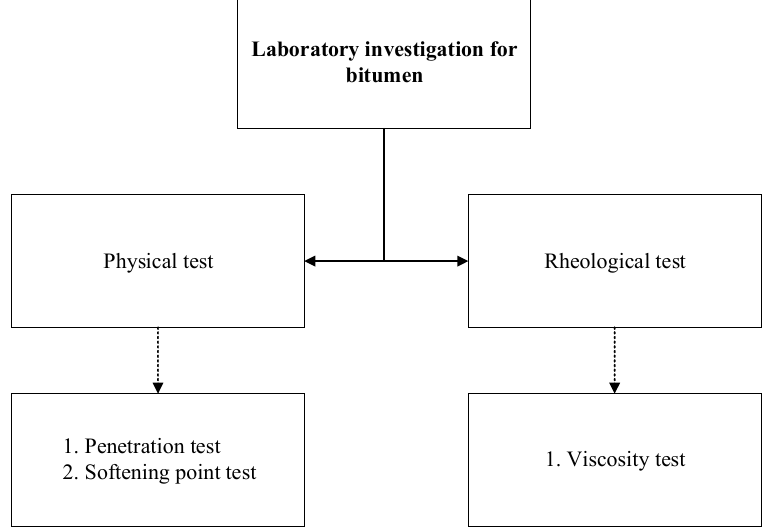
Figure 7. Adapted laboratory test flow for bitumen followed in this research.